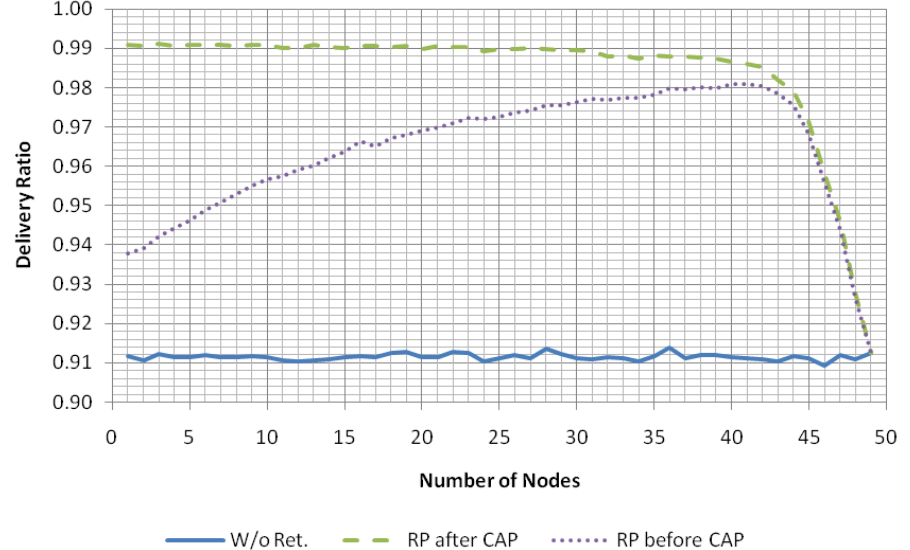
= 10 −2 (data) and 10 −4 bad